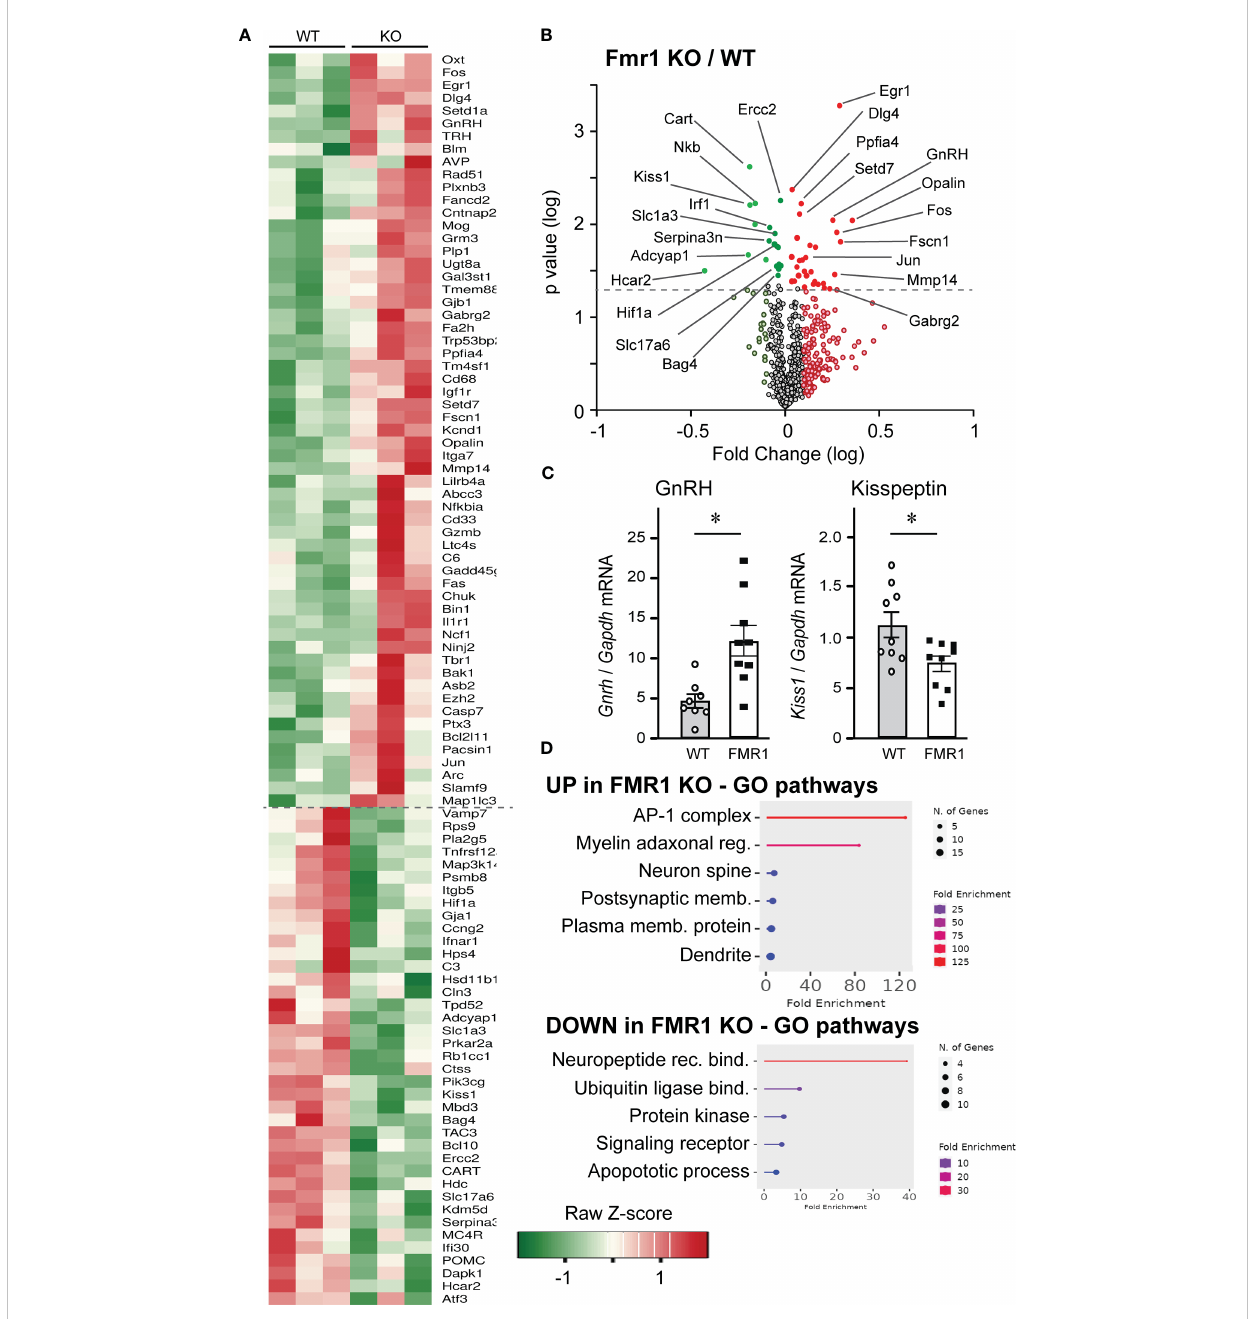
FIGURE 7 Nanostring analysis demonstrates signi fi cant changes in hypothalamic gene expression in Fmr1 KO mice. (A) Hypothalami from 3 mice per group were dissected and 50 ng RNA used in Nanostring analysis. Heatmap indicates gene expression changes in Fmr1 KO hypothalami that are <0.8-fold and >1.2-fold over WT. (B) Data were plotted as log fold change on x-axis vs . log p value on y-axis, and dashed line indicates signi fi cance. Red indicates genes that are increased in KO compared to WT mice, while green indicates genes that are decreased in KO compared to WT. Genes below the dotted line, light red and light green did not reach signi fi cance. (C) qPCR of the hypothalamus con fi rms changes in GnRH and kisspeptin expression. Each point represents one animal and bars represent group average. Statistical signi fi cance is indicated with *, determined by t-test followed by Tukey ’ s post hoc test. (D) Gene ontology pathway analysis indicates upregulated (top) and downregulated (bottom) pathways in the Fmr1 KO